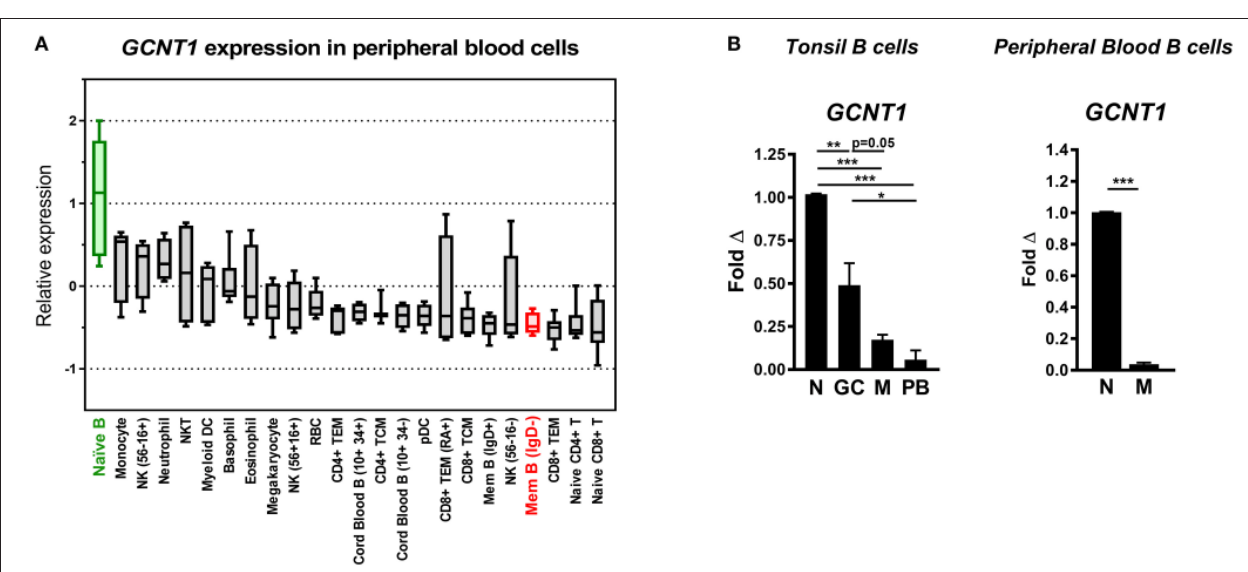
FIGURE 7 | cells were first treated with Arthrobacter ureafaciens sialidase. Data depict three (B,C,E) , eight (D) , nine ( F , Jacalin), or six ( F , HPA) distinct tonsil specimens. Statistics were calculated using a Kruskal–Wallis test with Dunn’s multiple comparisons test (D,F) or Welch’s unpaired two-tailed T-test (E). Throughout, bars and error bars depict the mean and SEM, respectively. ns, not significant, * p < 0.05, ** p < 0.01, *** p < 0.001. MFI, background subtracted geometric mean fluorescence intensity; N, naïve; GC, germinal center; M, memory; PB, plasmablast; Man, mannose; GalNAc, N-acetylgalactosamine; GlcNAc, N-acetylglucosamine; Gal, galactose; Sia, sialic acid; Fuc, fucose.